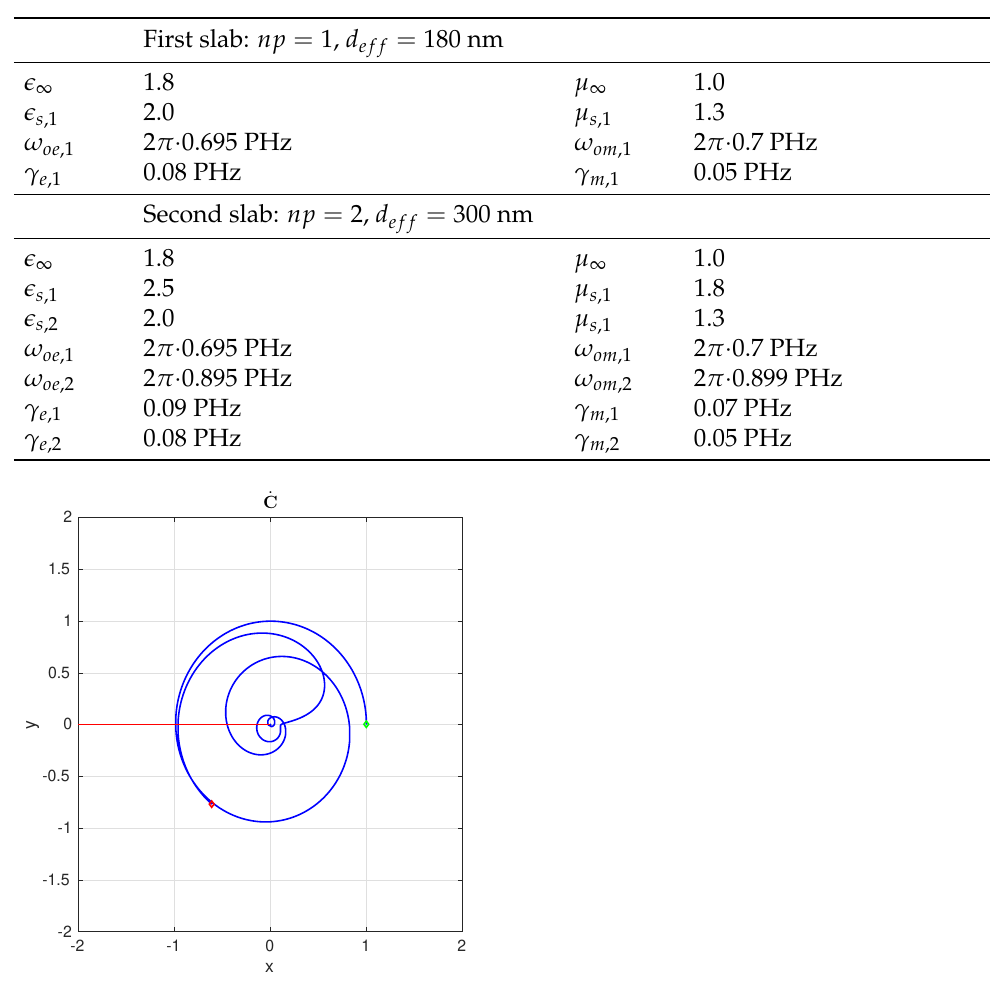
Table 1. Parameters for the Lorentzian model adopted in this study.